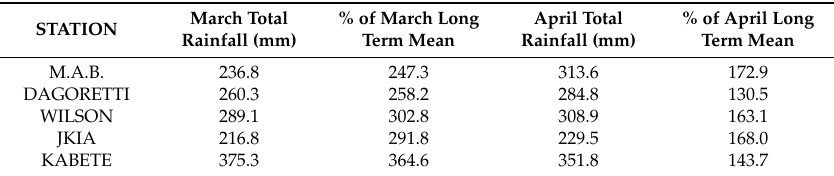
Table 1. Observed rainfall at five rainfall stations in